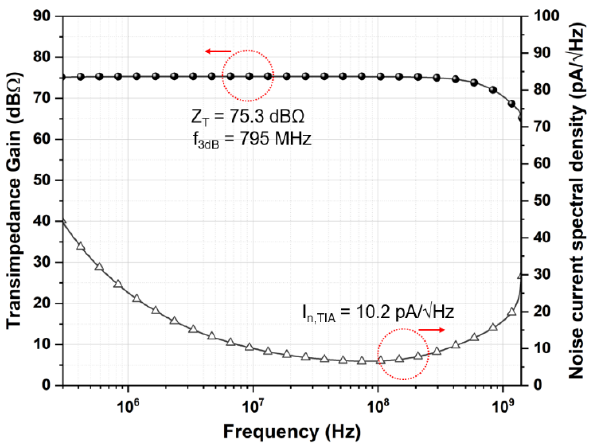
Figure 5. Simulated frequency response of the feedforward TIA.